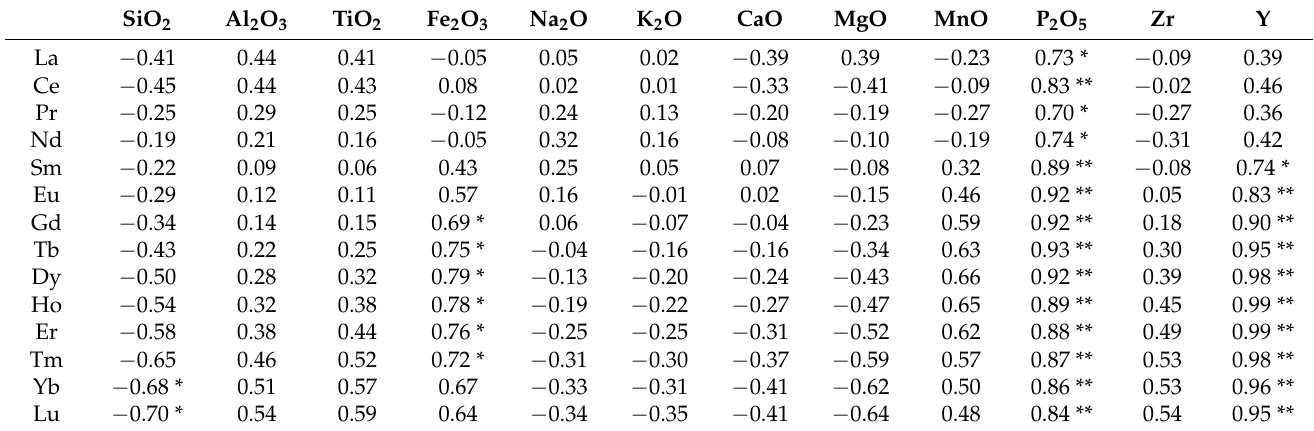
Table 1. Correlation coefficients (Pearson’s r) between REEs and some major and trace elements and REEs in the Lindai bauxite deposit, central Guizhou